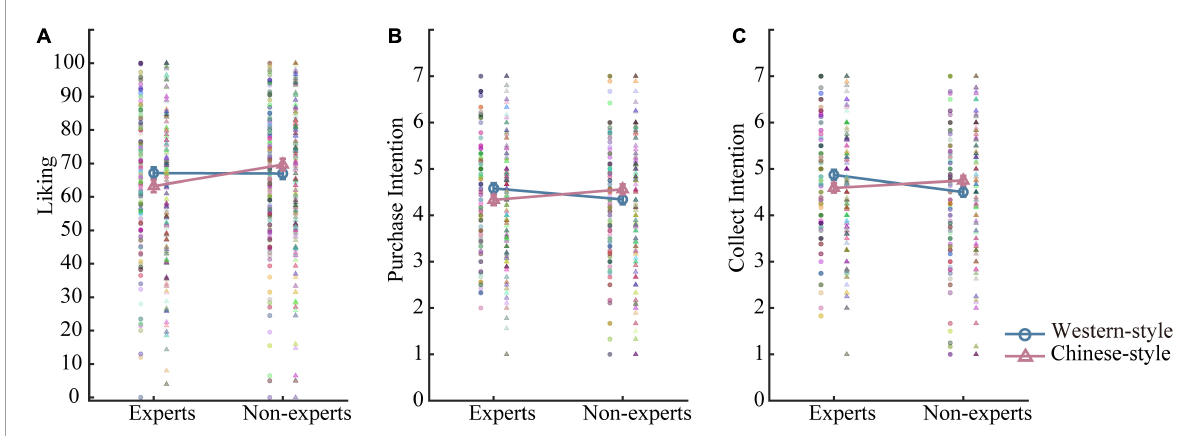
FIGURE3 Painting style (Western style and Chinese style) by art expertise (experts and non-experts) interaction. Consistent results were found for liking rating (A) , purchase intention (B) , and collection intention (C) . Error bars stand for ±